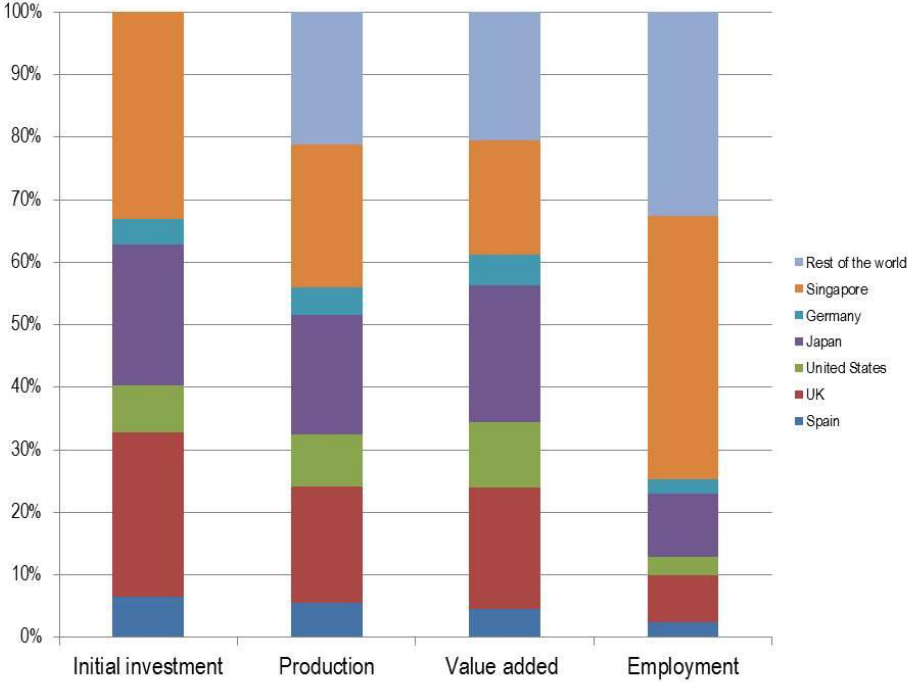
Figure 5. Socioeconomic impacts. The initial investment (understood as final demand) increases across the countries (via intermediates), adding value and generating employment throughout all the stages of production.